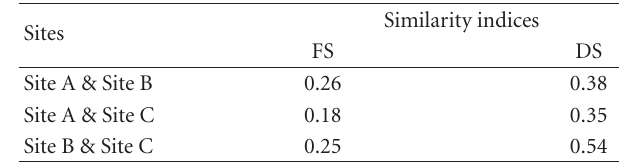
Table 4: Comparison of ciliate community similarity indices between the habitats/sites from Dongzhaigang mangrove forest, Hainan,